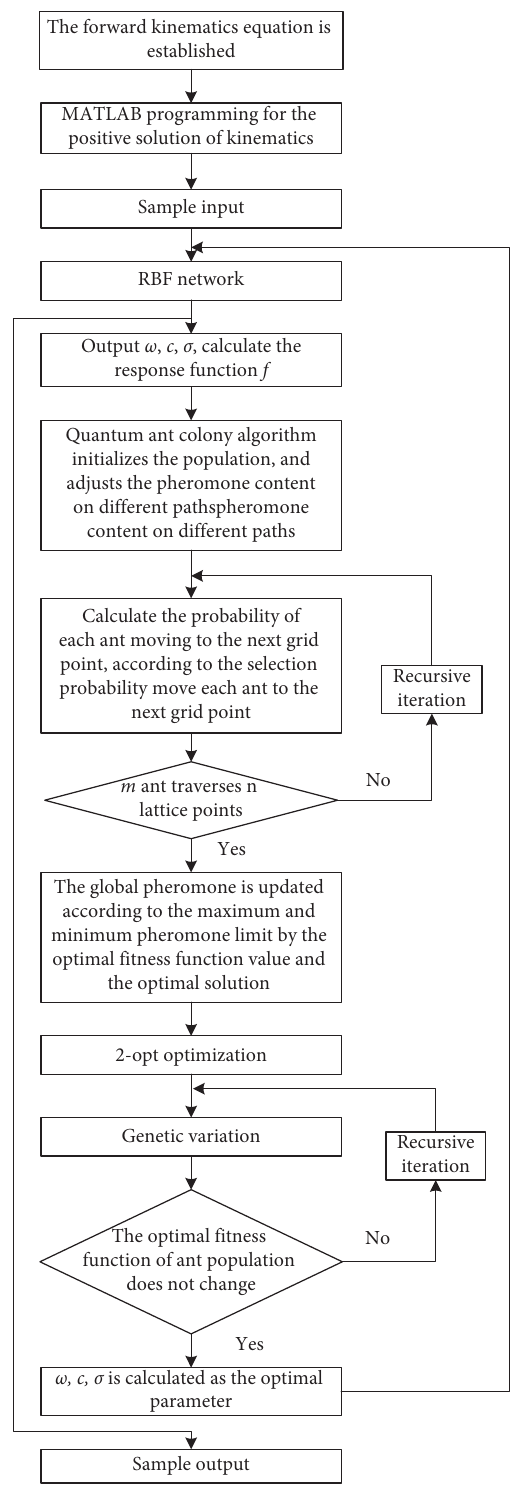
Figure 4: MQACA-RBF algorithm for inverse kinematics steps flow chart.